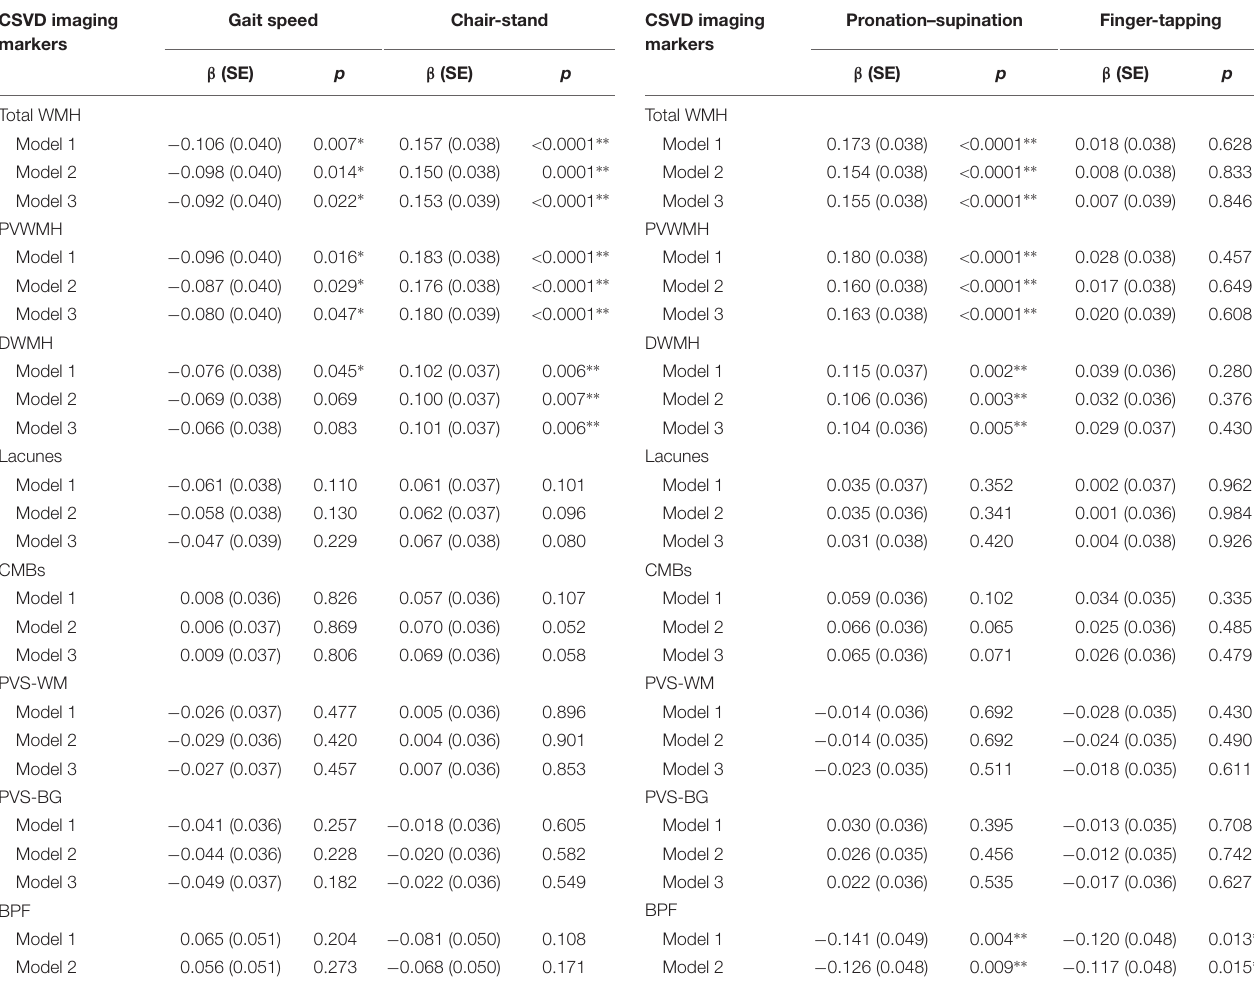
TABLE 3 | Associations between imaging markers of CSVD and motor function of upper